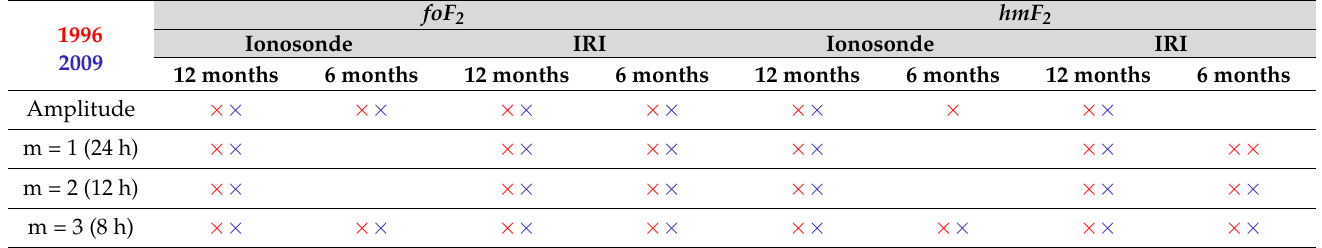
Table 1. Amplitude, diurnal, semidiurnal, and terdiurnal periodicity of hmF 2 and foF 2 of equatorial latitude for the ionosonde data and the IRI